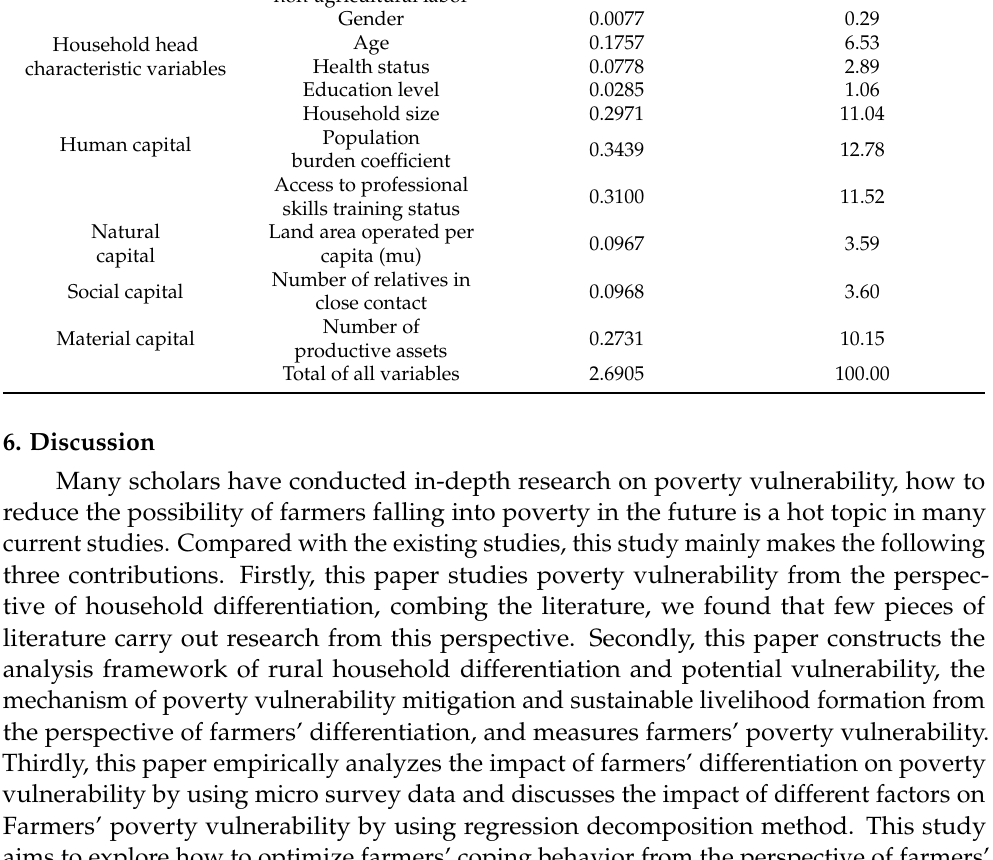
Table 4. Contribution of each explanatory variable to the vulnerability of farm households to poverty. Variable Variable Name Coefficient of Variation Contribution Rate (%) Farm household differentiation